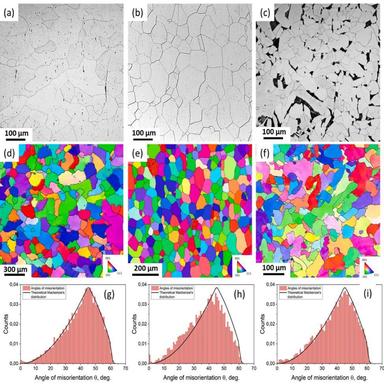
Microstructure of technically pure iron – (a, d, g), Fe-2.5%Si alloy – (b, e, h) and low-carbon steel S235JR – (c, f, i) characterised by the CLSM metallographic images – (a–c), EBSD inverse pole figure (IPF) maps – (d–f) and distribution histograms of angles of misorientation between grains superimposed with theoretical random Mackenzie's distribution – (g–i).